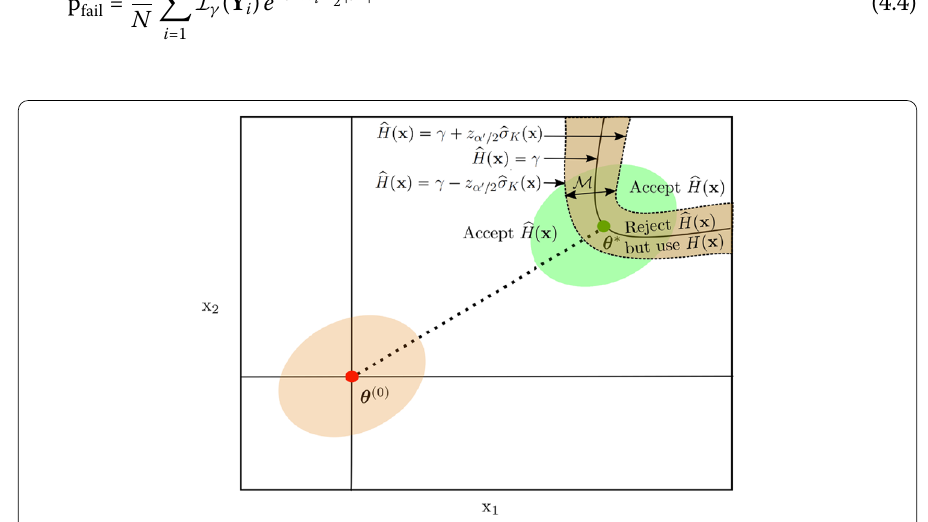
Figure 2 The visualization of the accept/reject